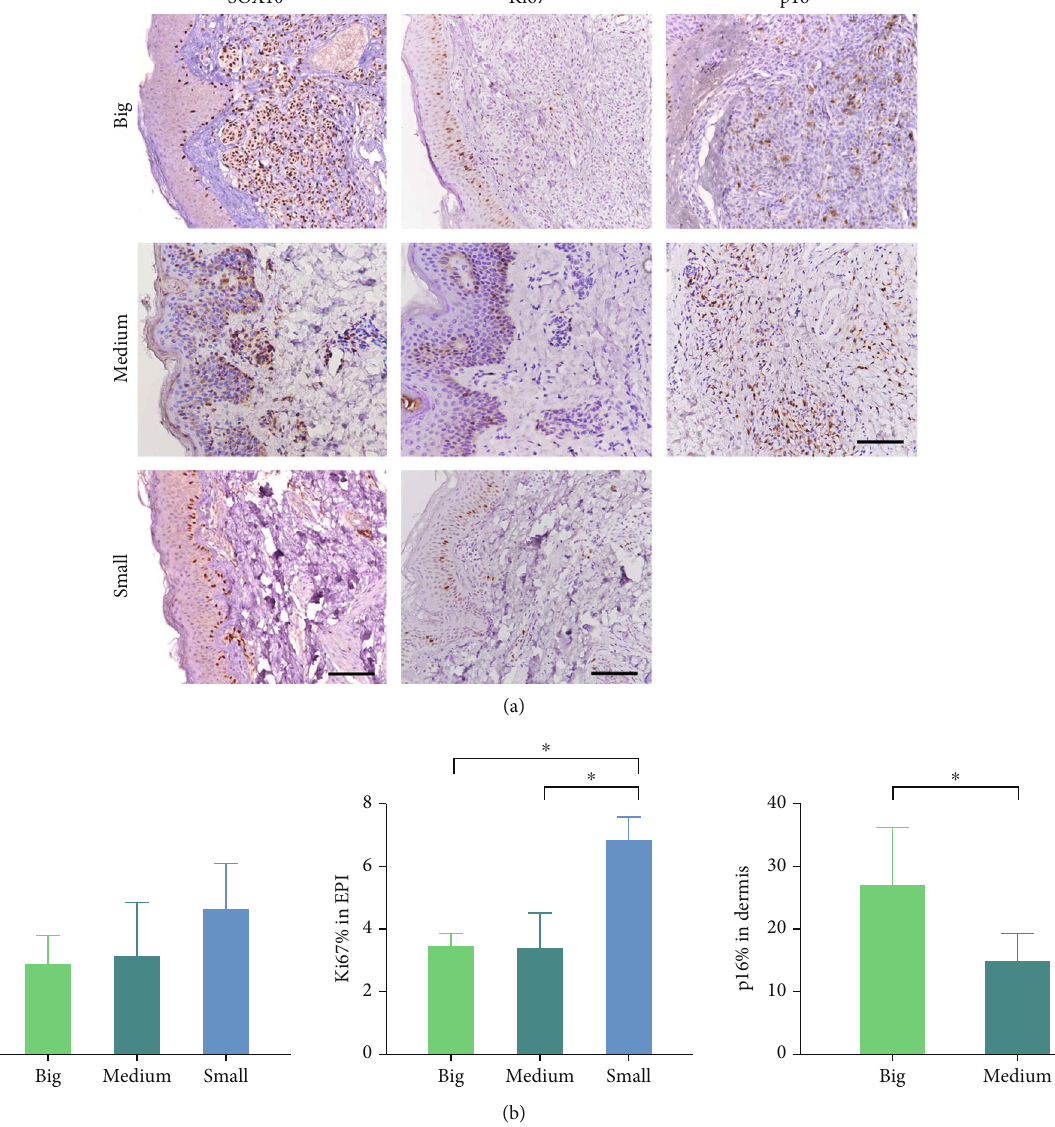
Figure 3: IHC staining of SOX10, Ki67, and p16 in big, medium, and small satellite nevi. (a) IHC staining of SOX10, Ki67, and p16 in big, medium, and small satellite nevi ( scale bar = 100 μ m). (b) The positively stained rates of SOX10, Ki67, and p16 were compared among big, medium, and small satellite nevi ( ∗ p value < 0.05). Table 1: Positively stained rates of SOX, Ki67, and p16 in the epidermis/dermis of lgCMN and satellite nevi in various sizes. Satellite nevus p lgCMN value Big Medium Small